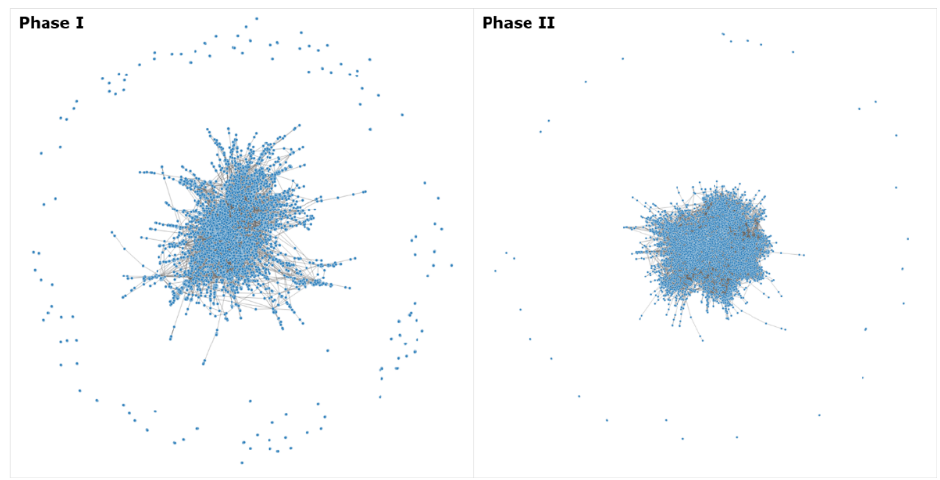
Figure 1. Visualization of the carbon trading networks.